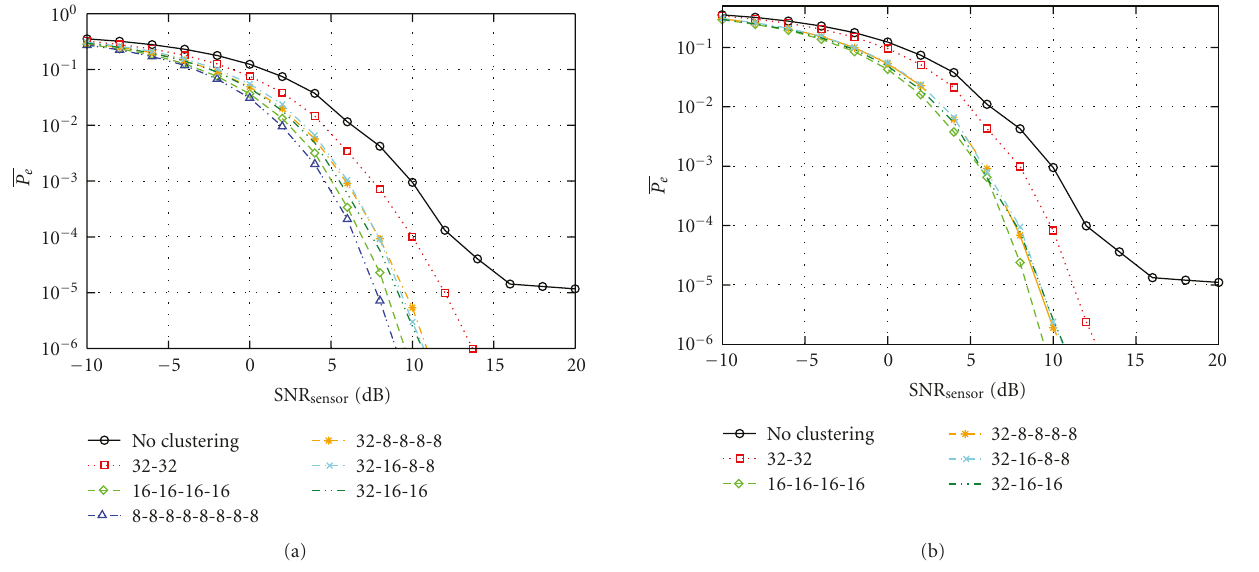
Figure 7: P e as a function of the sensor SNR, for di ff erent clustering configurations, ideal communication links, and the IEEE 802.15.4 MAC protocol. Case (a): absence of weighing; case (b): presence of weighing.